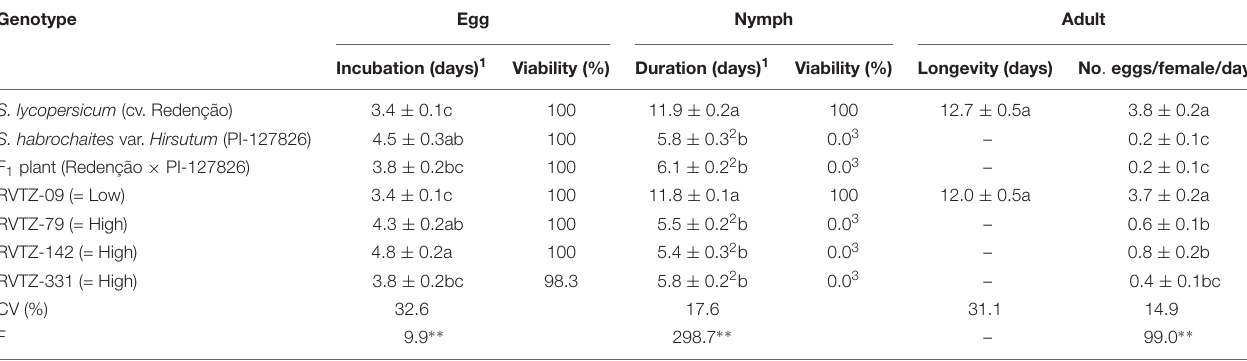
TABLE 3 | Biological parameters [duration (days ± SE) of egg incubation and nymphal development time, egg and nymph viability (%), longevity of adults, and fecundity rate] of Tetranychus urticae kept on leaf disks of different tomato genotypes. Genotype Egg Nymph